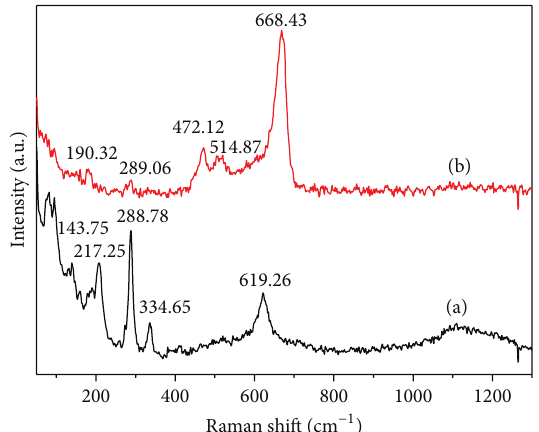
Figure 5: Raman spectra of CuO NRs (a) and CuO/Co 3 O 4 coaxial heterostructures